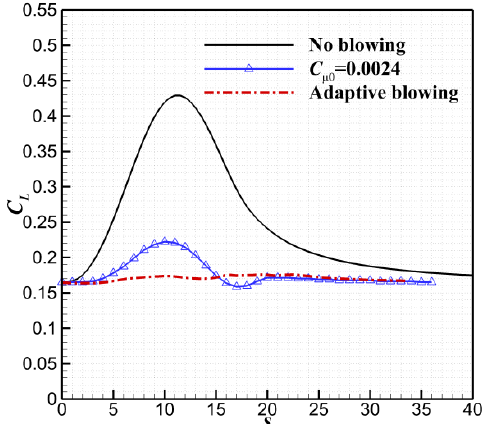
Figure 6. The gust response with and without Circulation Control (from [106]).